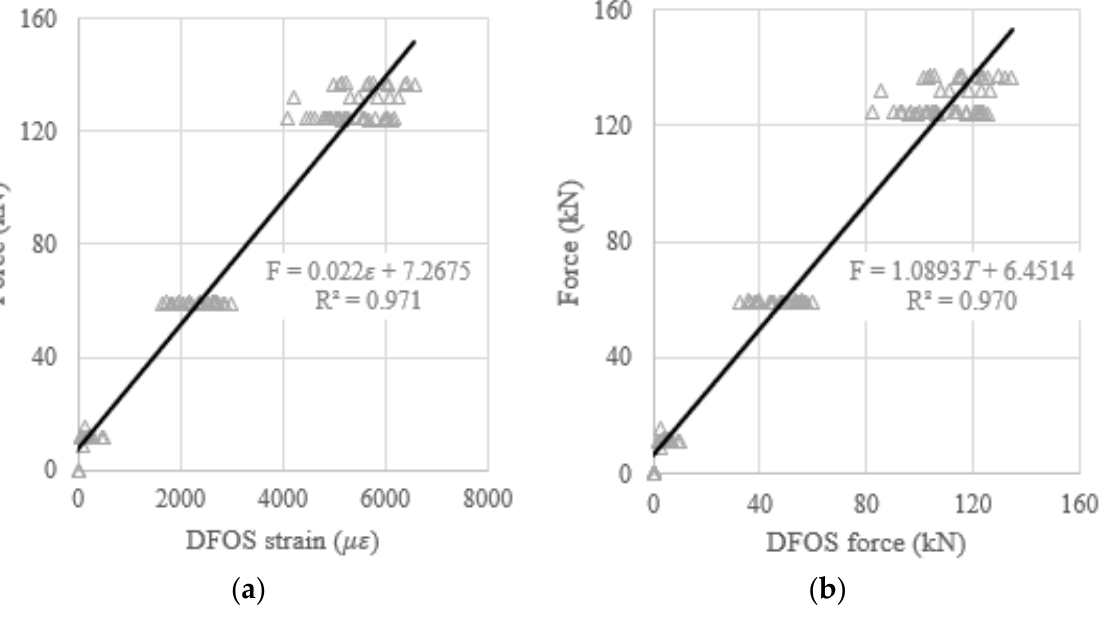
Figure 17. ( a ) Prestressing force versus DFOS-min. strain; and ( b ) prestressing force versus DFOS min. strain-calculated force.